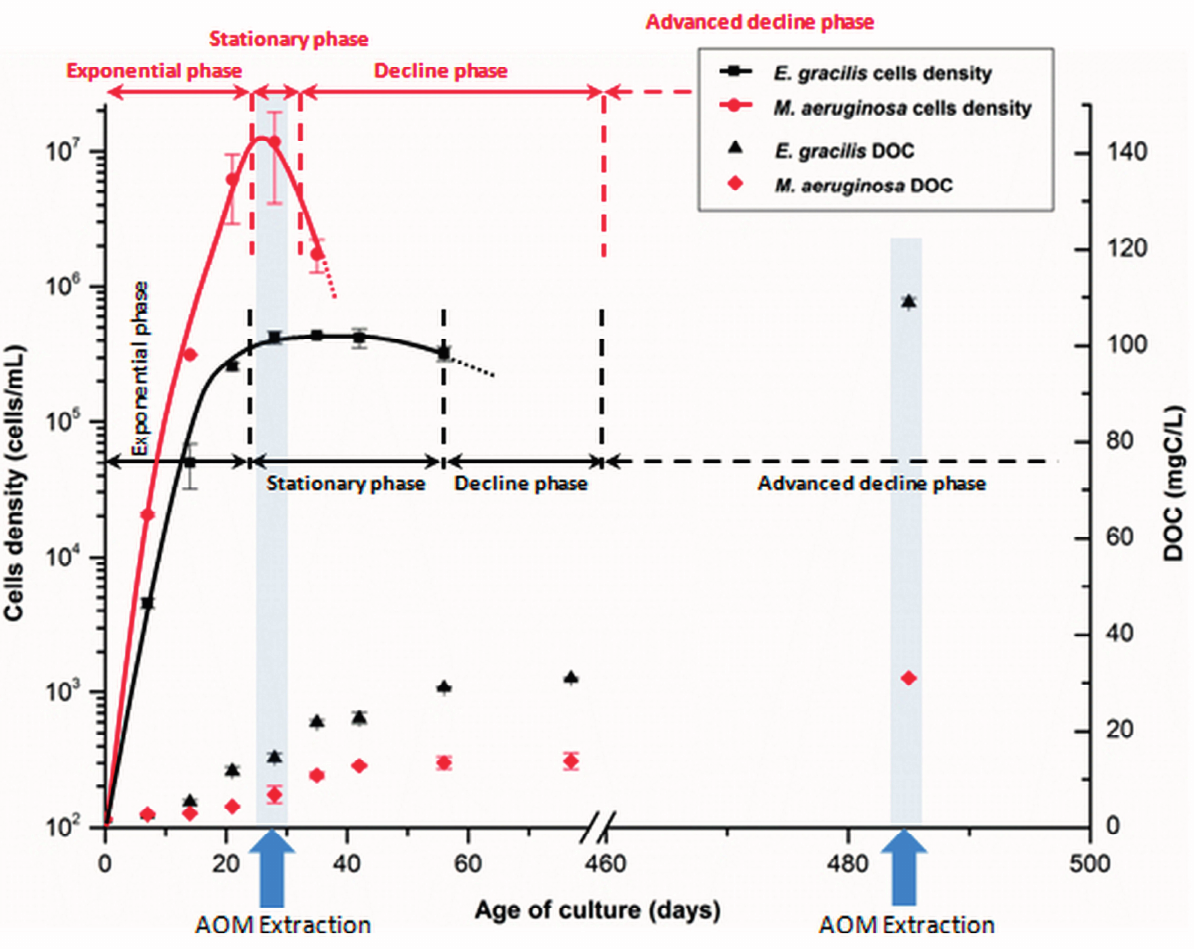
Figure 1. Growth curves and extraction time points of E. gracilis and M. aeruginosa. Cells densities were determined by flow cytometry in a previous study